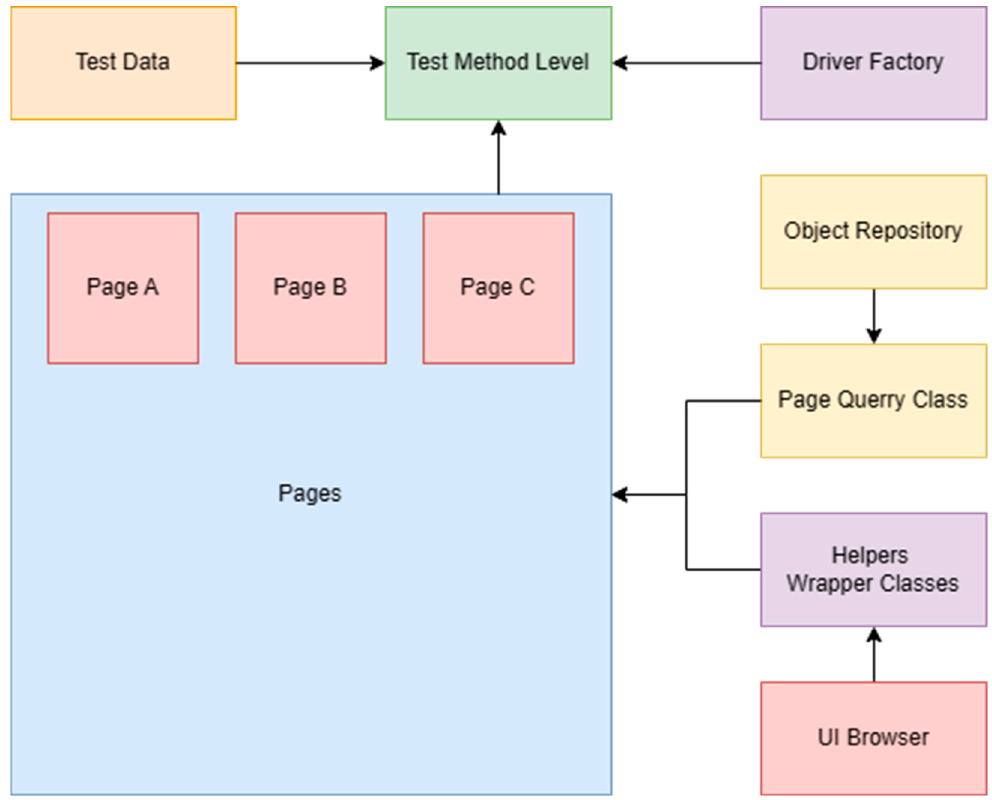
Figure 9. Page Object Model design pattern applied on a webpage testing.